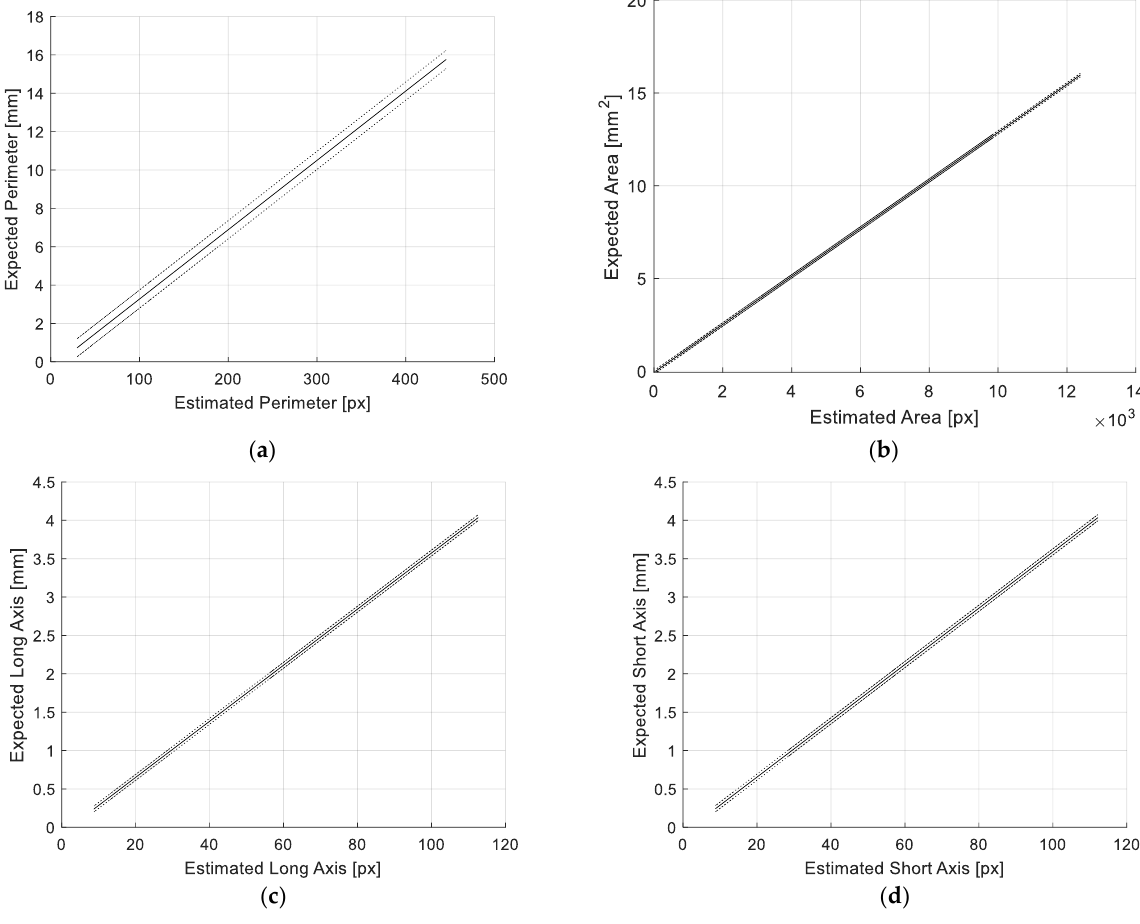
Figure 7. Calibration diagrams for ( a ) perimeter, ( b ) area, ( c ) long and ( d ) short axes. The uncertainty bandwidth in the 3σ limit is also shown. Table 1. Conversion coefficients, uncertainty bandwidth and resolution of the vision tool.